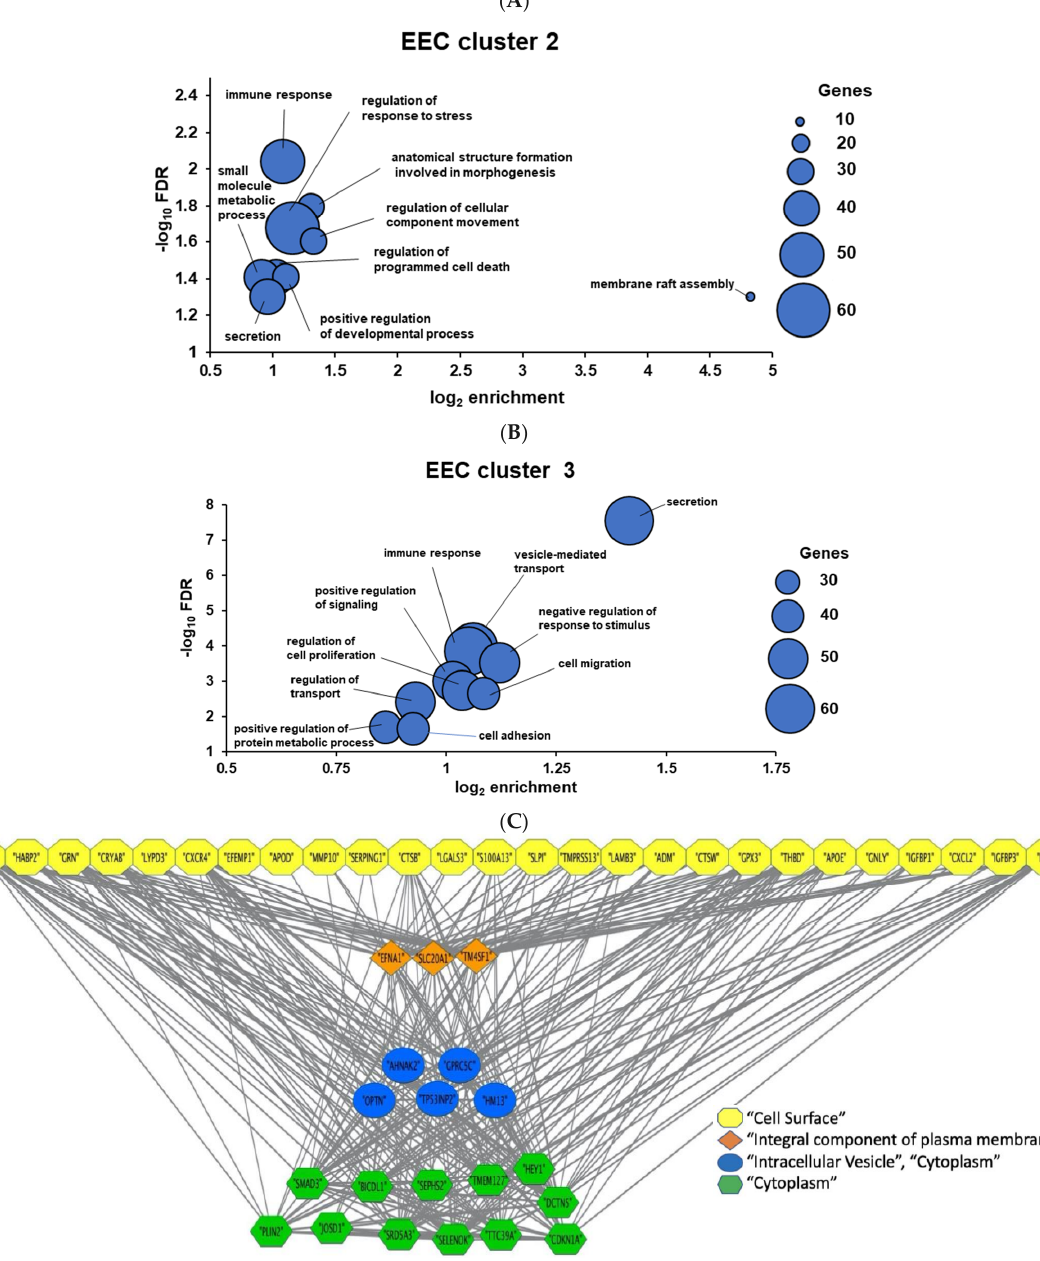
Figure 4. Gene Ontology (GO) of endometrial epithelium networks reported via indirect action analysis of hypernetwork clusters 2 and 3 (( A , B ), respectively). The X axis reports gene enrichment in the GO term and the Y axis the statistical significance of over-representation (negative log 10 false discovery rate). Dot size reflects the number of genes in the sample matching the GO term. ( C ) Cys- toscope network visualisation of genes in cluster 3. Edges with weight above a threshold of 0.9 are displayed. Yellow nodes denote cell surface genes that interact with TE. Downstream genes are